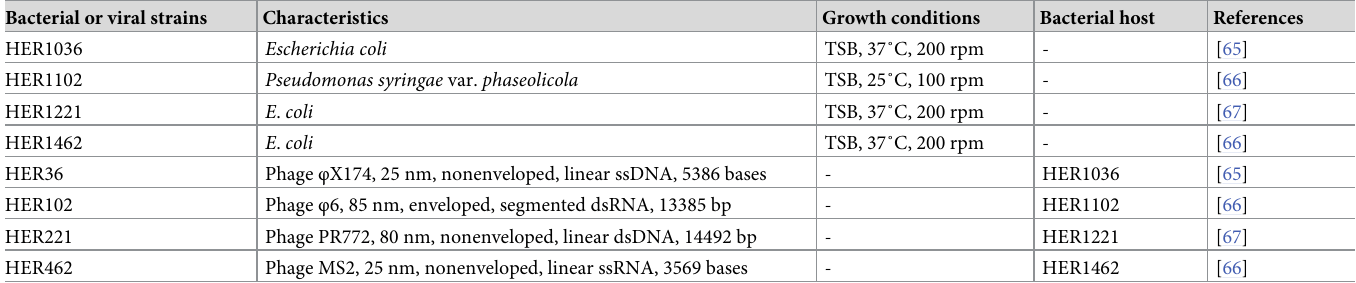
ssDNA: single stranded DNA, ssRNA: single stranded RNA, dsDNA: double-stranded DNA, dsRNA: double-stranded RNA, bp: base pairs